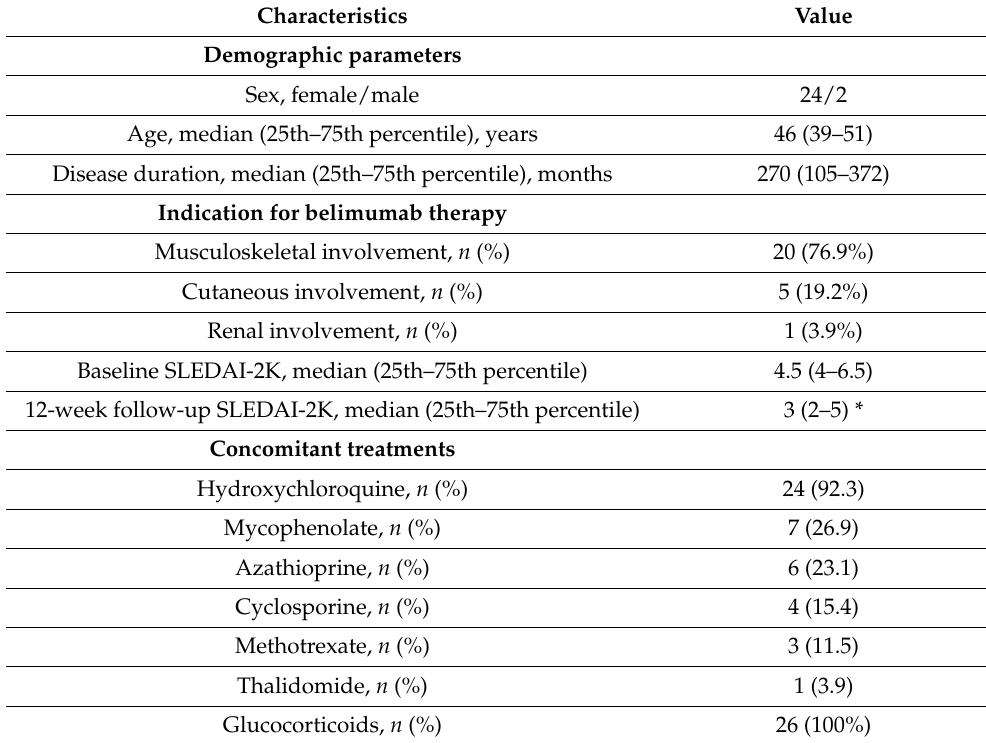
Table 1. Demographic, clinical, and therapeutic features of SLE patients ( n =